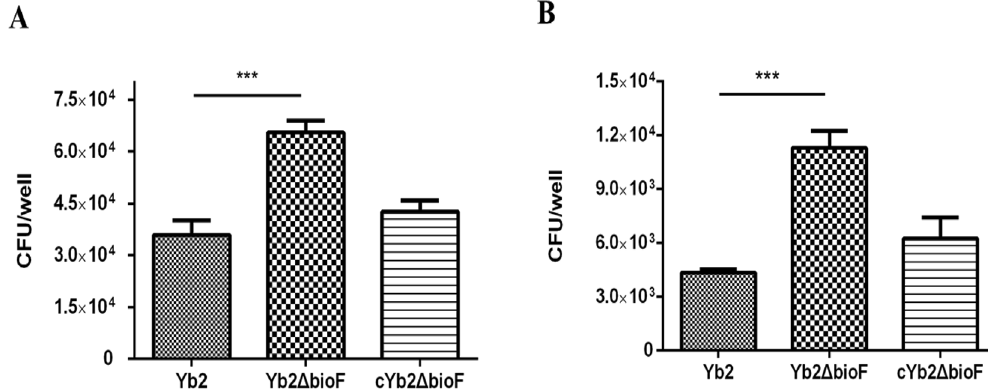
Figure 4. Bacterial adherence and invasion assays. ( A ) Adherence assay. ( B ) Invasion assay. Strains Yb2, Yb2 Δ bioF and cYb2 Δ bioF were tested on duck embryo fibroblast cells. The data represent the number of bacteria bound to or invaded into duck embryo fibroblast cells in each well of a 24-well plate. The error bars represent standard deviation calculated from three independent experiments performed in triplicate ( *** p < 0.001).